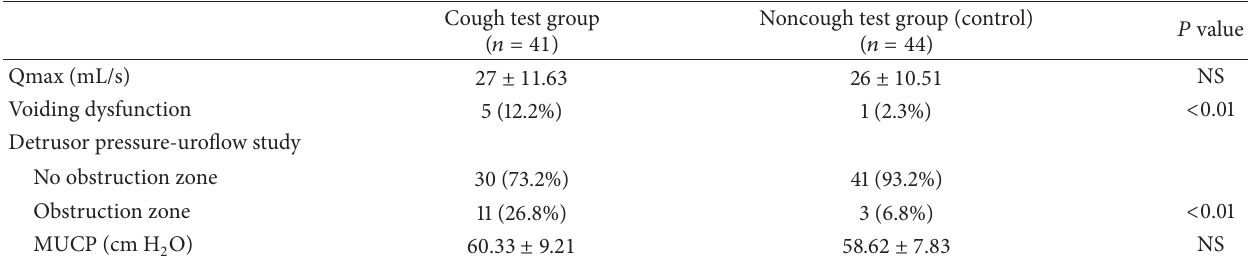
Table 3: Postoperative urodynamic